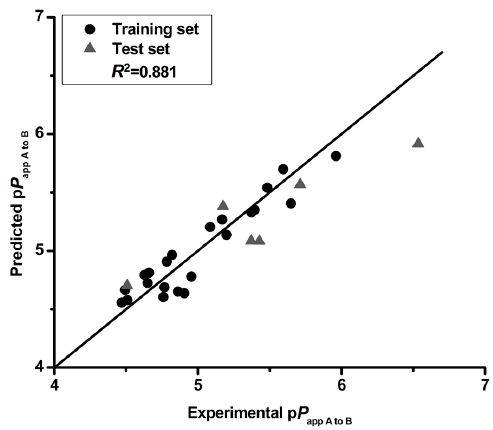
Figure 1. The experimental p P app A to B versus predicted p P app A to B .